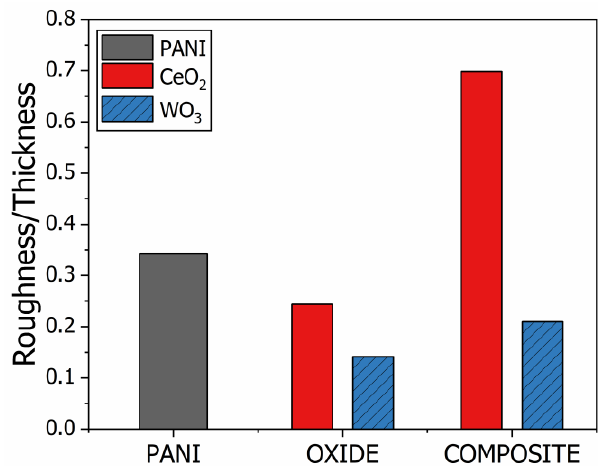
Figure 7. Analysis of the roughness-to-thickness ratio parameter for both sets of films. The red filled columns show the results for the CeO 2 group of films, while the patterned blue filled columns show the results for the WO 3 group of films.